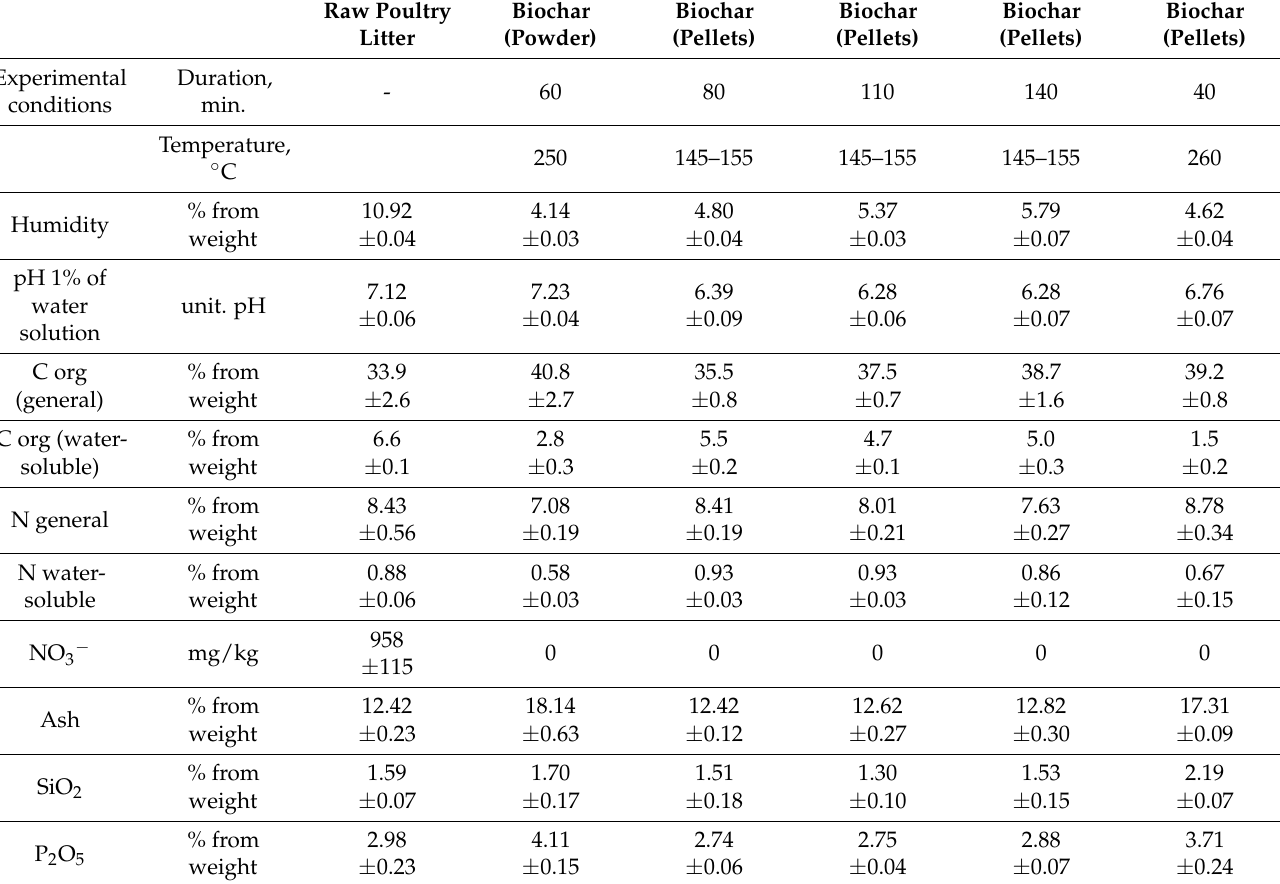
Table 1. Results of chemical analysis of initial material and bio-coal obtained from poultry